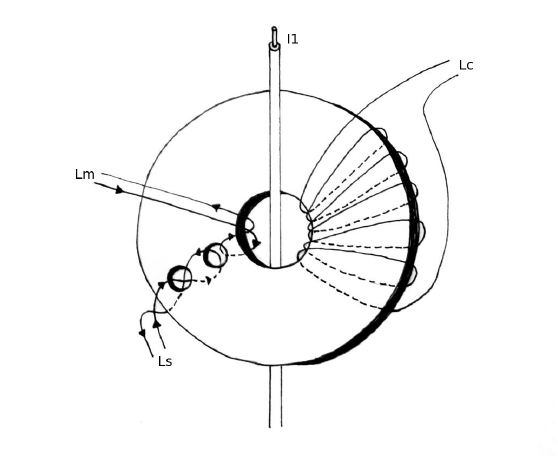
Figure 5. DC-CT core with Platiše Flux Sensor, primary and compensation winding.